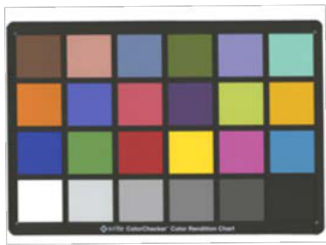
Figure 1. Gretag Macbeth  ColorChecker  Chart The terrestrial laser scanning was performed with our Leica ScanStation 2. This instrument is a medium speed TOF laser scanner that integrates a dual-axis compensation and a low- resolution colour digital camera. This old fashion but still valid panoramic (360º H x 270º V field-of-view) laser scanner is able to achieve survey-grade accuracy for each point at 134 m (considering 18% albedo). The dominant colour of the scanner is green with a wavelength of 532